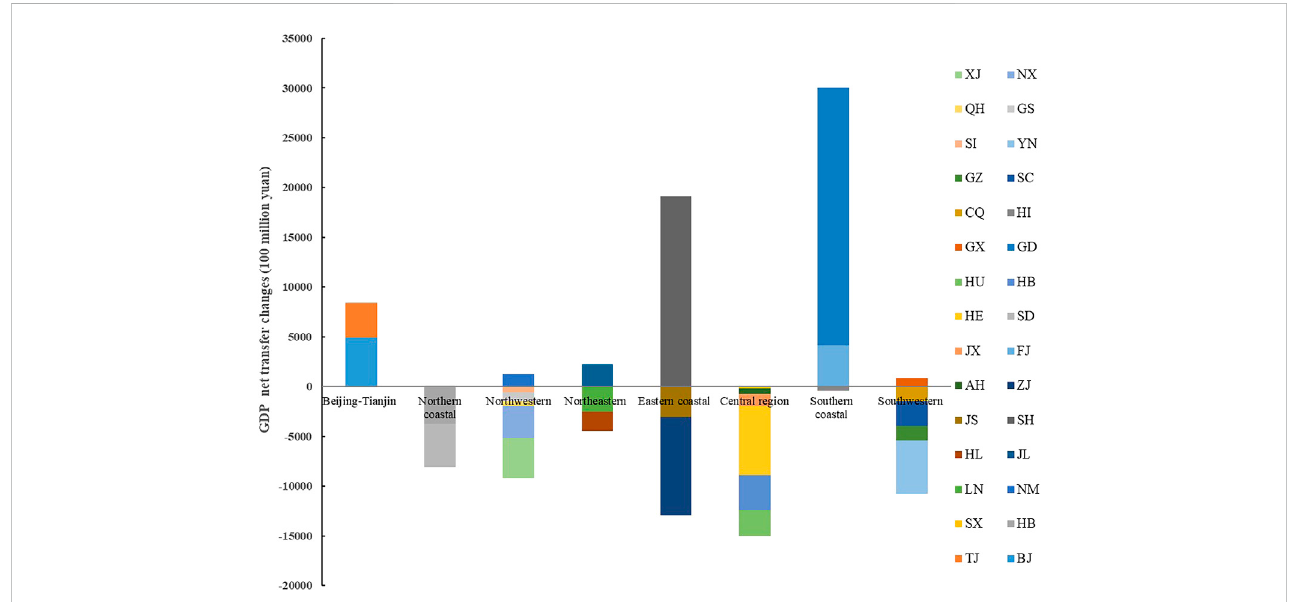
FIGURE 3 Embodied GDP net transfer in inter-provincial trade from 2012 to